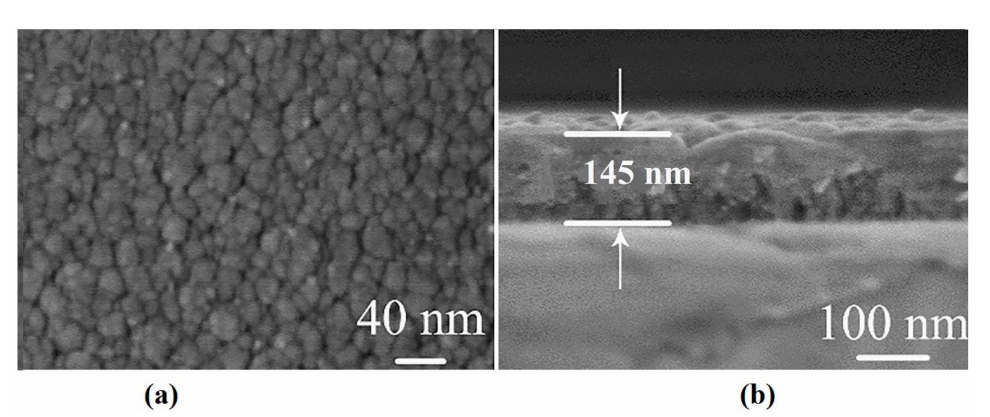
Figure 3. ( a ) SEM surface image, ( b ) SEM cross-section image with the thickness.